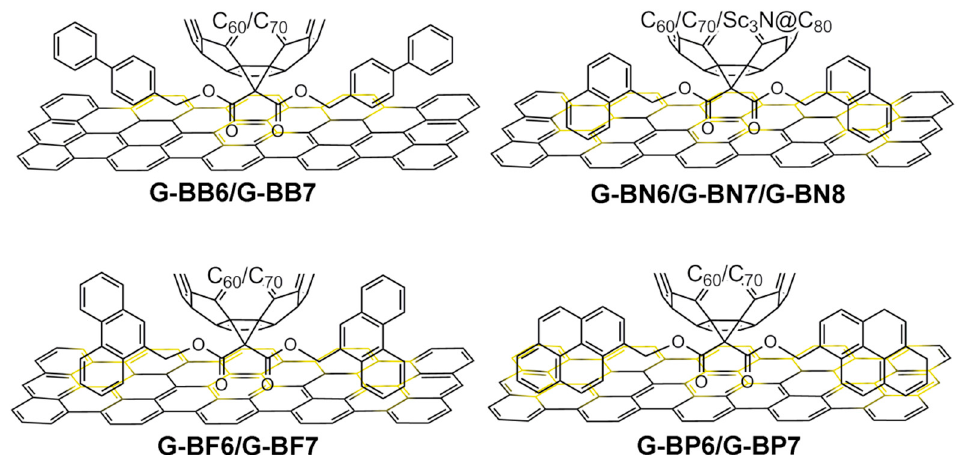
Figure 3. Scheme for preparation of graphene functionalized with aromatic rings bis-functionalized fullerene malonates via π – π stacking.